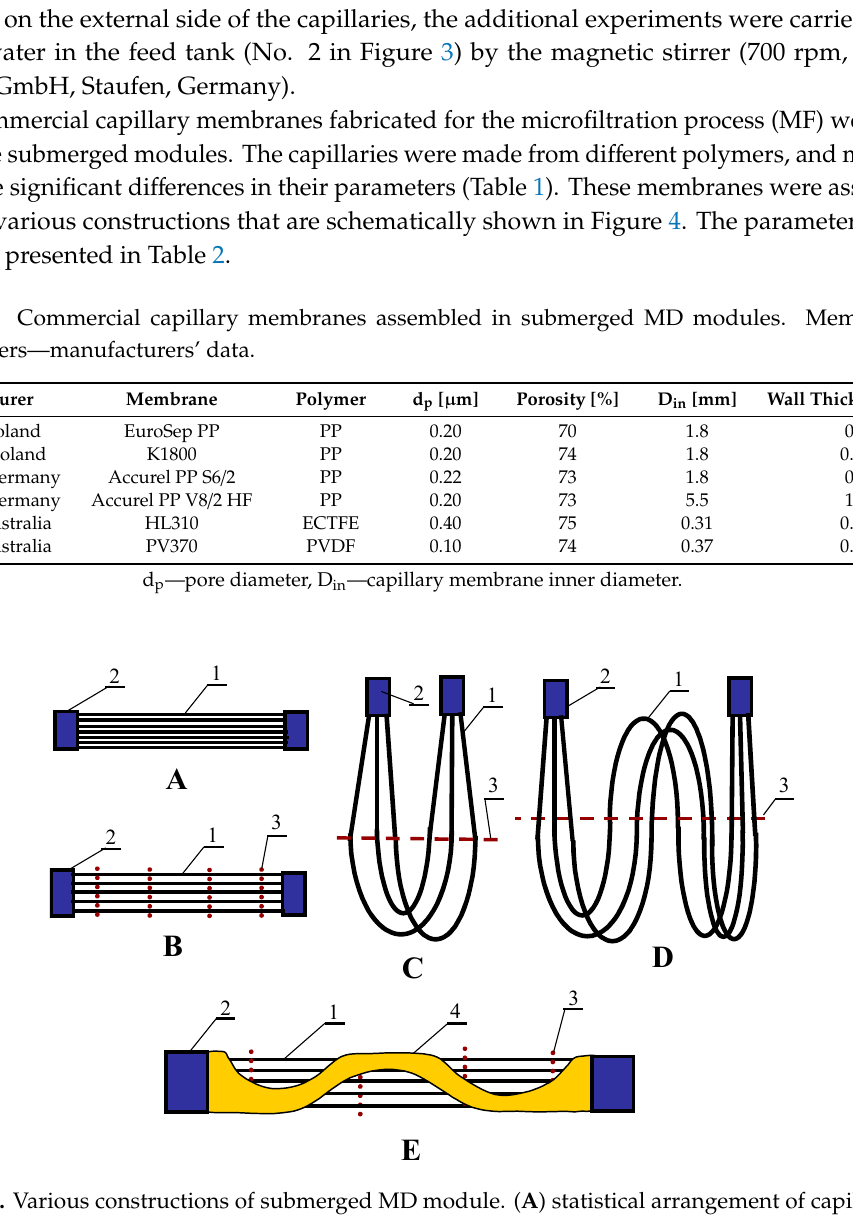
B Table 3. Parameters of capillary MD modules.